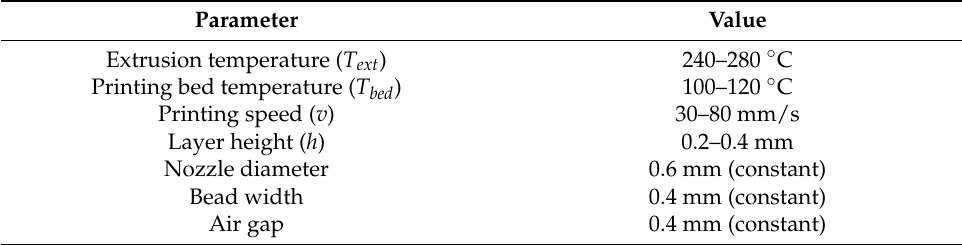
Table 1. Evaluated ranges of process parameters.